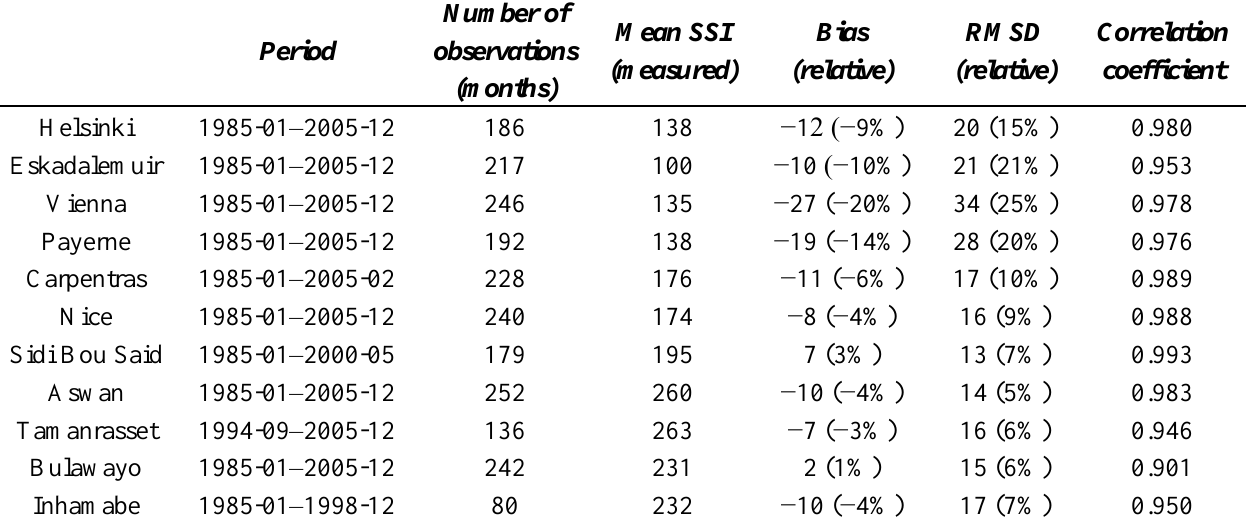
Table 4. Comparison between HC-1 and ground-based measurements of monthly mean of SSI (in W/m 2 ). RMSD: root mean square difference. In brackets, quantities are relative to the mean